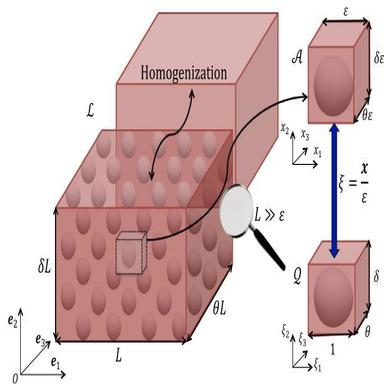
Heterogeneous and homogeneous 3D domain L with periodic cell A and the corresponding nondimensional cell Q.